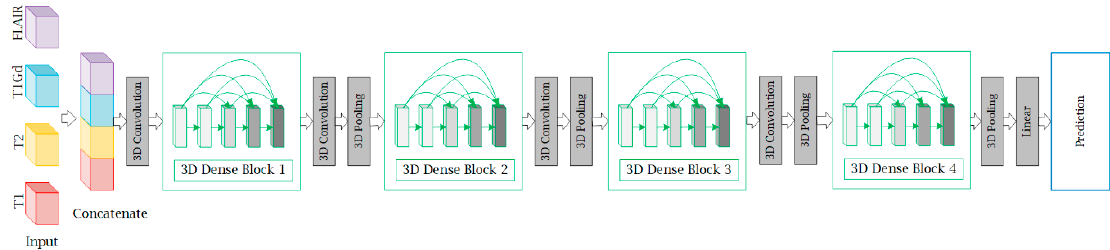
Figure 2. A schematic illustration of multimodal three ‐ dimensional DenseNet (M3D ‐ DenseNet). Our M3D ‐ DenseNet takes four MRI sequences (l, w, h) as input and then concatenates the four modalities as a four ‐ dimensional matrix (4, l, w, h). All convolutions and poolings in the network are 3D operations, and are the same in the four dense blocks. T1: native; T1Gd: post ‐ contrast T1 ‐ weighted ; T2: T2 ‐ weighted; FLAIR: T2 fluid attenuated inversion recovery. Table 2. Multimodal three ‐ dimensional DenseNet architecture.